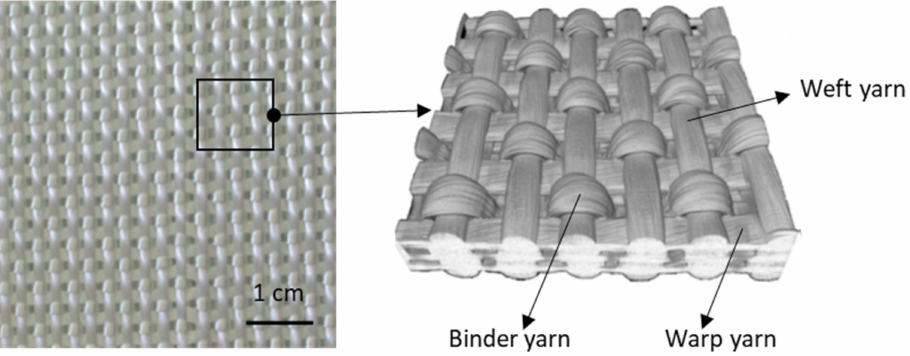
Figure 1. Structure of the 3D non-crimp orthogonal woven fabric by X-ray tomography and its